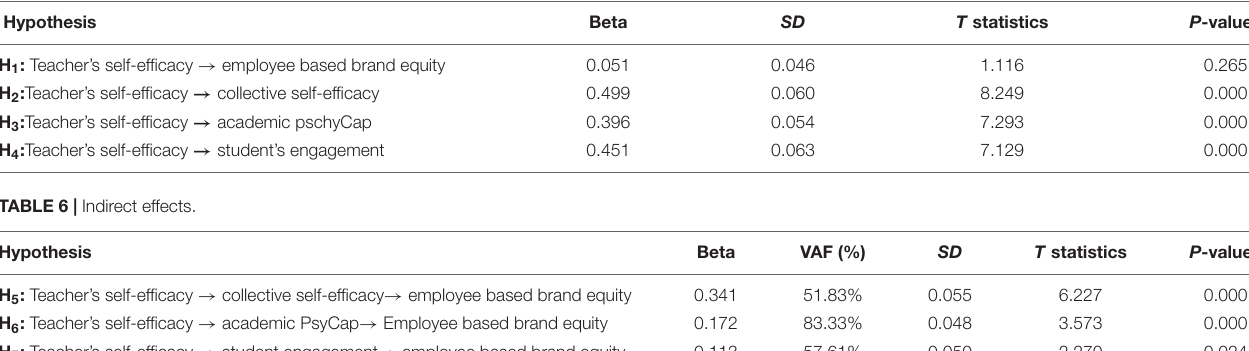
TABLE 5 | Direct effects. Hypothesis Beta